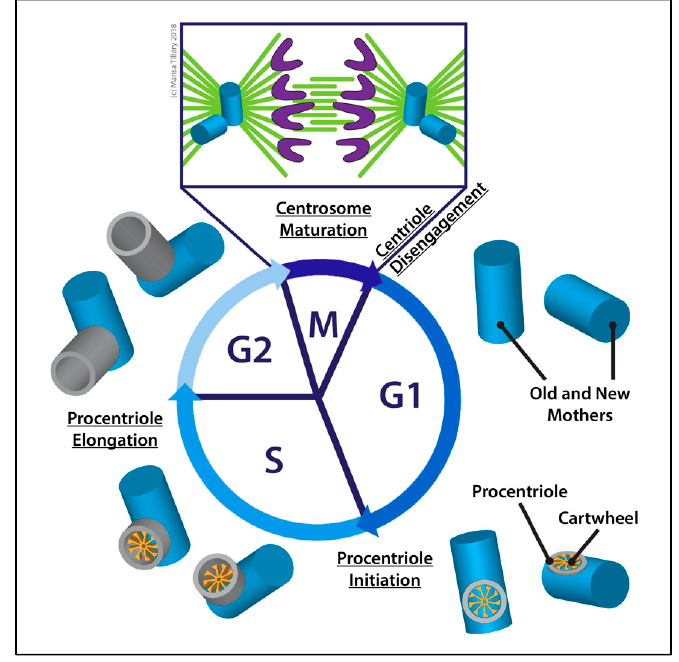
Figure 2. Centriole duplication cycle. Centriole pairs disengage in late mitosis, licensing mother and daughter centrioles to duplicate. Procentriole (grey) genesis begins with cartwheel (orange) assembly at the base of the old and new mother centrioles (blue) as cells enter S phase. Procentrioles elongate during S and G2 phases. During mitosis, DNA (purple) is segregated to each daughter cell through the activity of the centrosomes. PCM is recruited and the procentriole is converted to a mature mother capable of duplicating once the cell passes through mitosis. In late mitosis, the centriole pair disengages and the old and new mothers are licensed to duplicate.